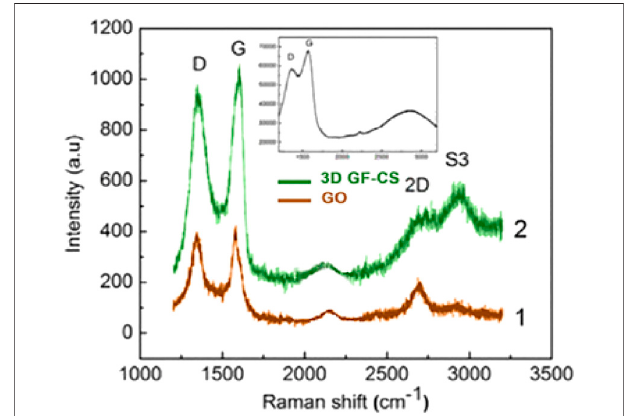
FIGURE 4 | Raman spectra for 3D